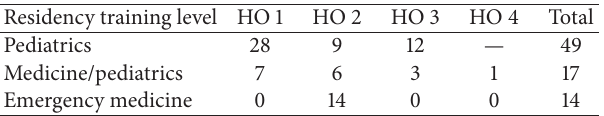
Table 1: Medical training level and specialty of house officer participants in the baseline high fidelity neonatal resuscitation simulation